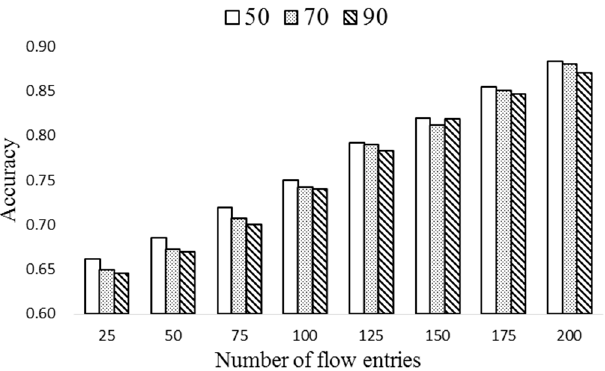
Figure 7. The prediction accuracy vs size of flow table.